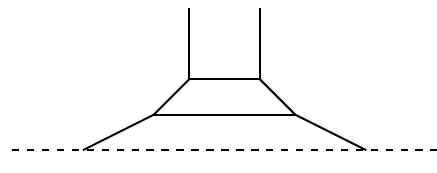
Figure 9. 5-brane web diagram for SO(4).